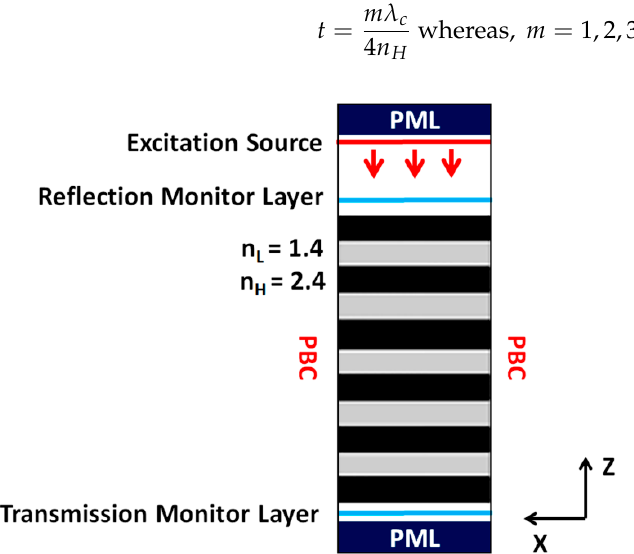
Figure 1. Simulation model depicting an excitation source, DBR structure, reflection, and transmission monitoring layers with the application of boundary conditions.